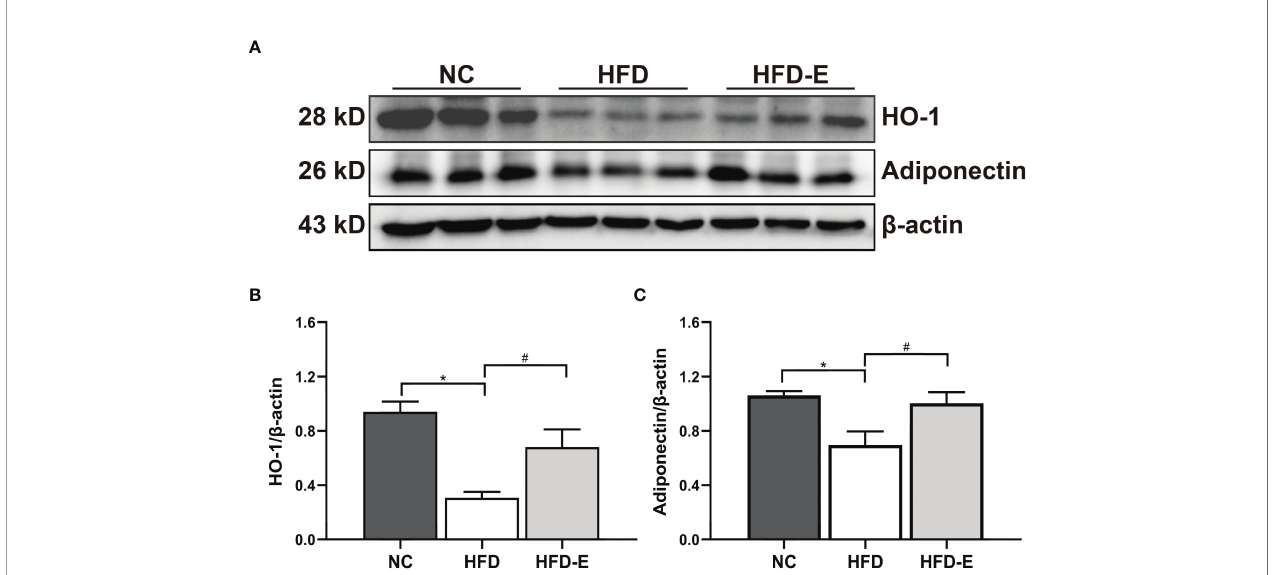
FIGURE 5 | EMPA induced HO-1-adiponectin protein expressions. (A – C) Immunoblotting analysis and quanti fi cation of HO-1 and adiponectin. n = 6/group; Data are means ± SEM. *P< 0.05 vs. NC; # P < 0.05 vs.